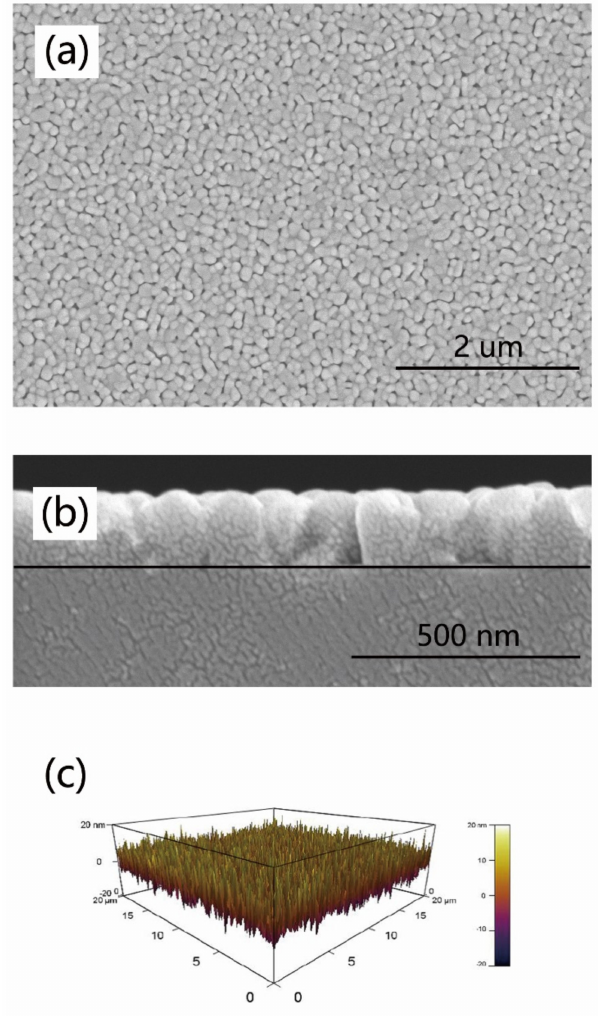
Figure 3. SEM images of ( a ) the surface and ( b ) cross-section of GFO films on STO (111) substrates. ( c ) 3-D AFM image of the